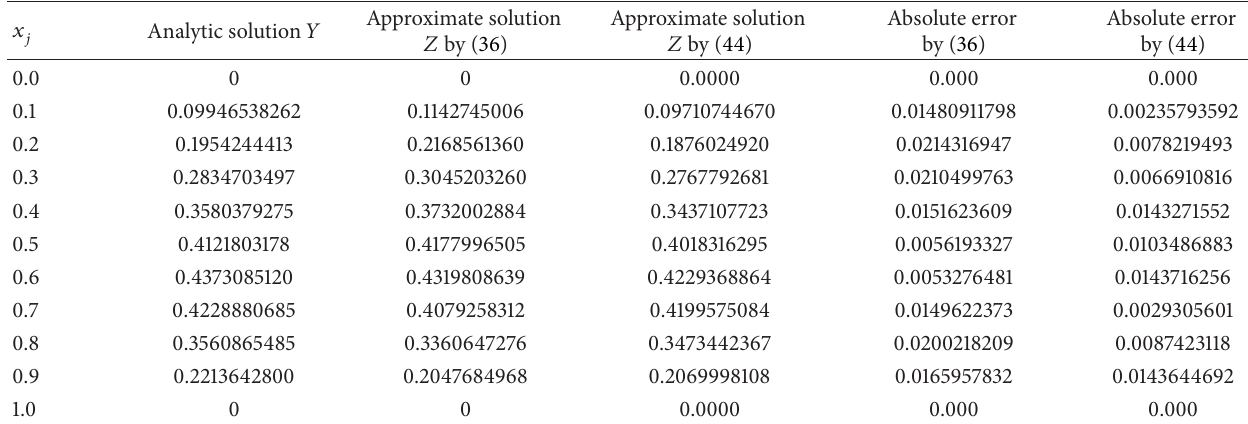
Table 3: Solutions and error estimation of Example